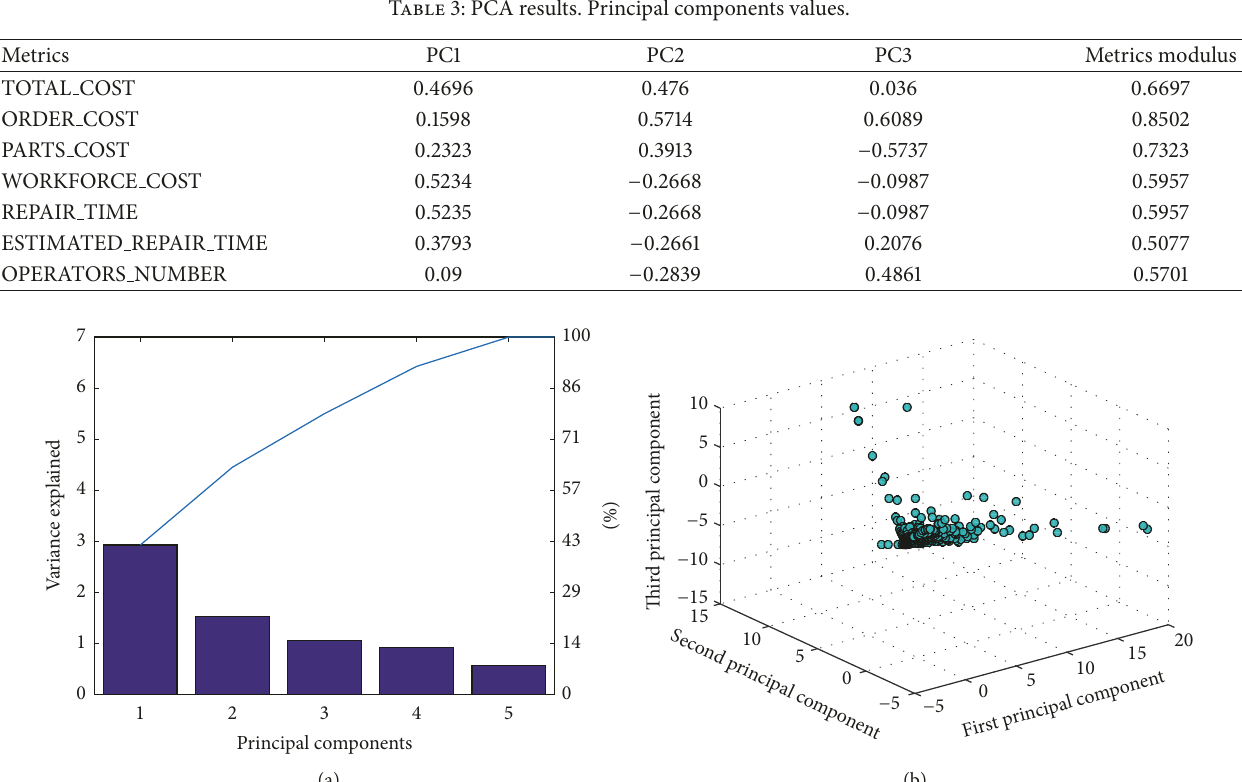
Figure 4: (a) Principal components variance; (b) projected data on principal